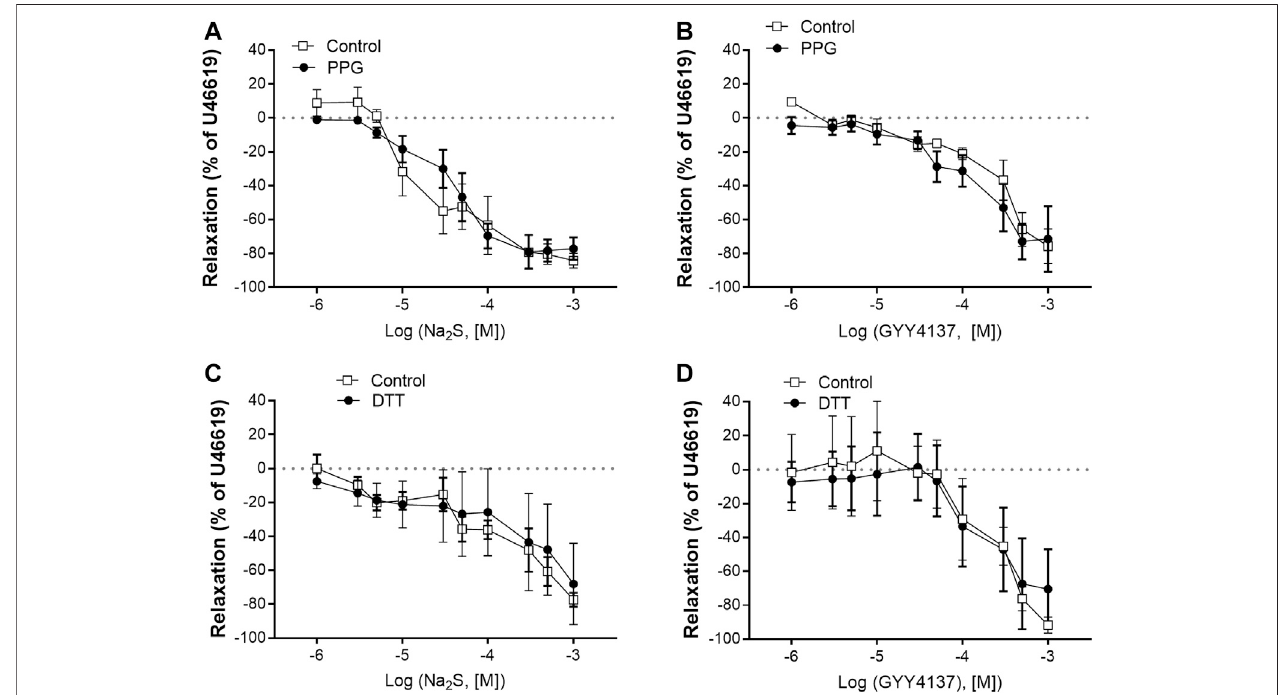
FIGURE4| Effect ofthe cystathionine γ -lyase (CSE) inhibitor,PPG, and DTT on Na 2 S and GYY4137 relaxations inrat mesentericarteries (A) Effect ofPPG(1 mM) onNa 2 Sinducedvascularrelaxation (B) effectofPPGonGYY4137inducedvascularrelaxation (C) effectofDTT(1 mM)onNa 2 Sinducedvascularrelaxation (D) effectof DTT on GYY4137 induced vascular relaxation. Where no error bars are indicated, error lies within dimensions of the symbol. * p < 0.05, two-way ANOVA. All data is represented as mean ± SEM ( n (cid:2) 5 –